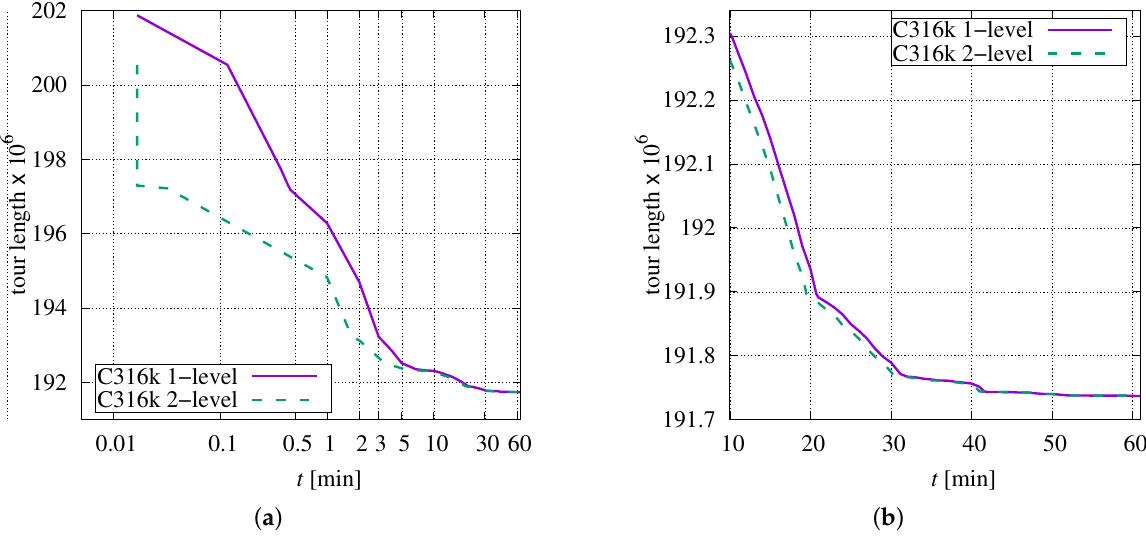
Figure 11. Progress of optimization as function of time for C316k.0 and two alternative data structures: ( a ) over 60 min; ( b ) over last 50